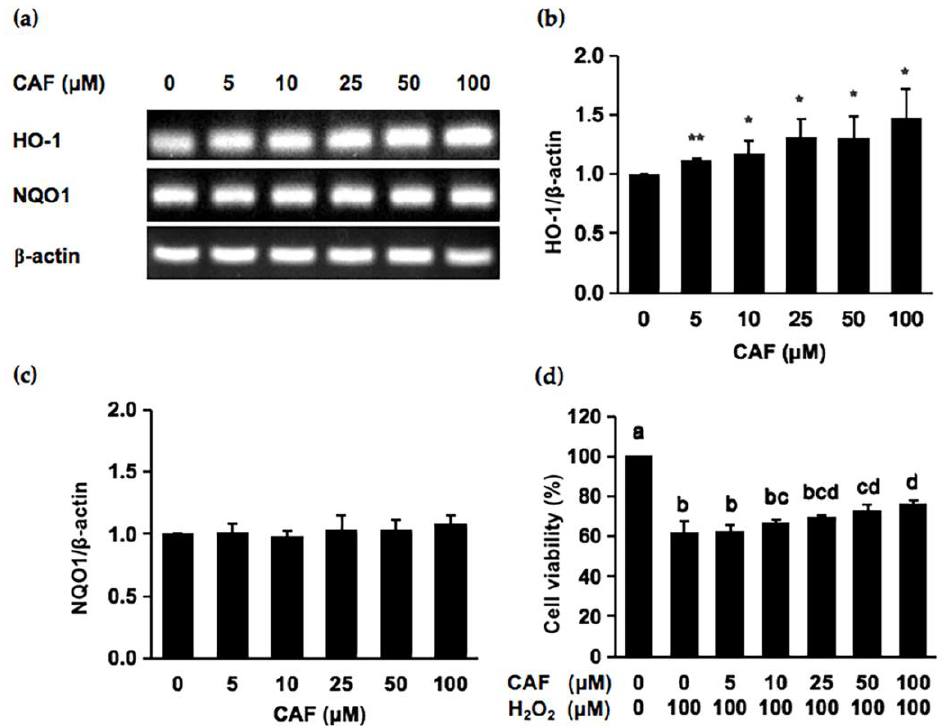
Figure 2. Modulating effect of CAF on the gene expression of cytoprotective proteins and the hydrogen peroxide-induced cytotoxicity in Hepa1c1c7 cells. ( a – c ) Hepa1c1c7 cells were pretreated with various concentrations of CAF for 6 h and the mRNA levels of heme oxygenase-1 ( HO-1 ) and quinone oxidoreductase 1 ( NQO1 ) were analyzed by RT-PCR. All values were expressed as means ± SD of three separate experiments. ** p < 0.01; * p < 0.05 vs. control. ( d ) Hepa1c1c7 cells were pretreated with various concentrations of CAF for 6 h, followed by treatment with 100 μM of hydrogen peroxide for 6 h. Cell viability was measured using a MTT assay. All values were expressed as means ± SD of three separate experiments. The different letters above the bars indicated significant differences among the treatments for each condition ( p < 0.05).